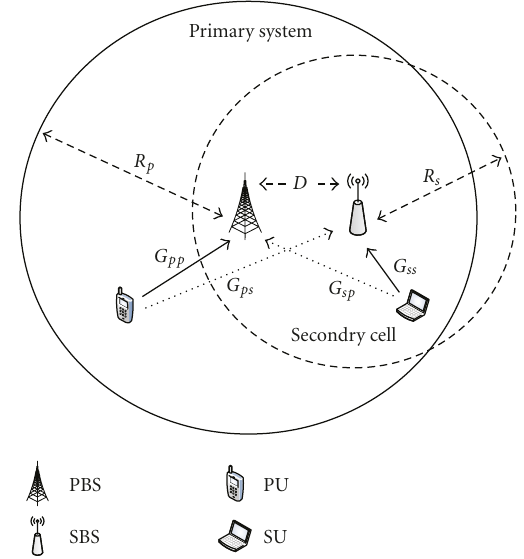
Figure 1: Cognitive radio networks with one primary system and one secondary cell.